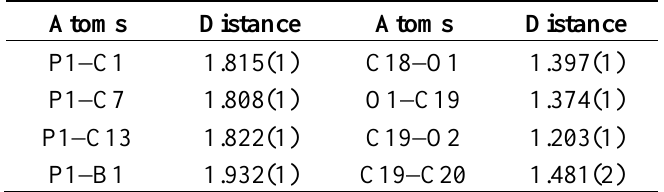
Figure 1. A view of the structure of the title molecules in crystals of 4 showing the atom labeling scheme. Displacement ellipsoids are drawn at the 50% probability level. Table 2. Selected atom distances (Å) in 4